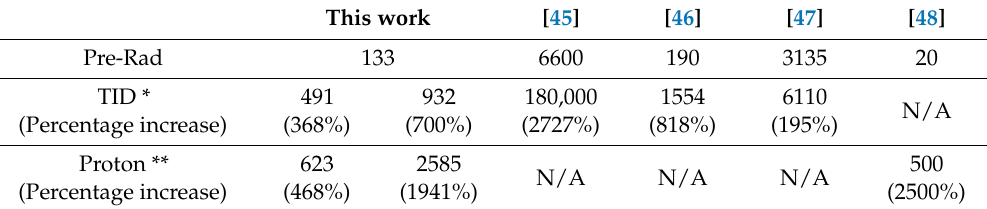
Table 3. Comparison of the dark current with other image sensors (unit: e − /s).